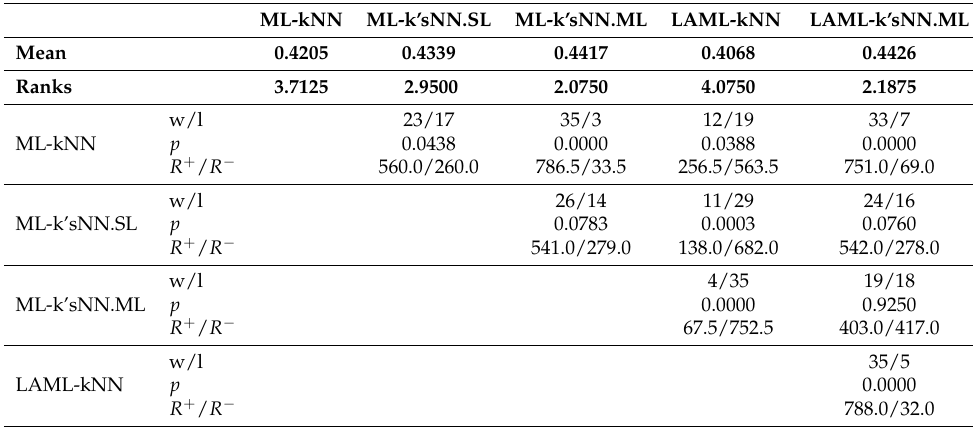
Table 3. Comparison of the different methods using F1